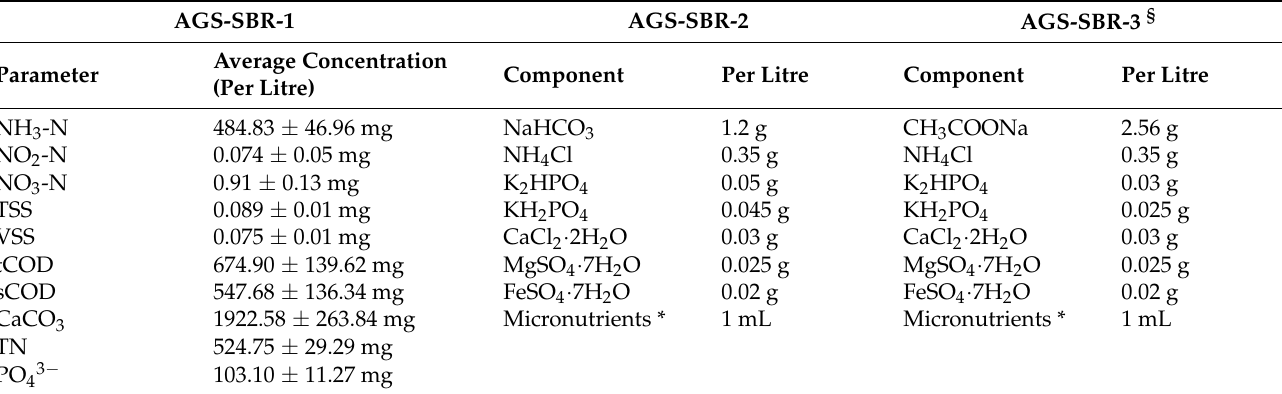
Table 5. Characteristics of centrate and synthetic centrate used for AGS-SBR-1, 2 & 3.